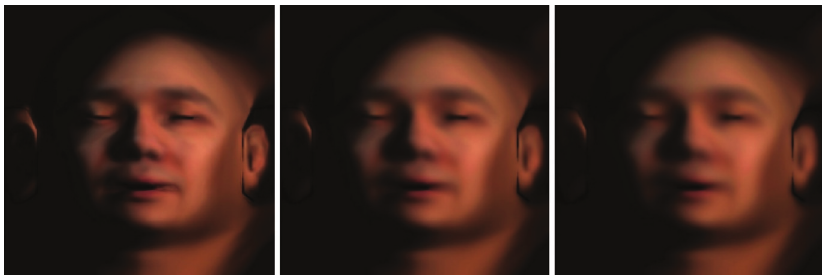
Figure 18. Multiple Gaussian Convolution Filtering: SSS Requires Six Separate Convolution Filter Operation on Texture Space Render Result to Compute Skin Diffuse Profile. Three Pictures Show the First, Third, and Sixth Filtering Result.